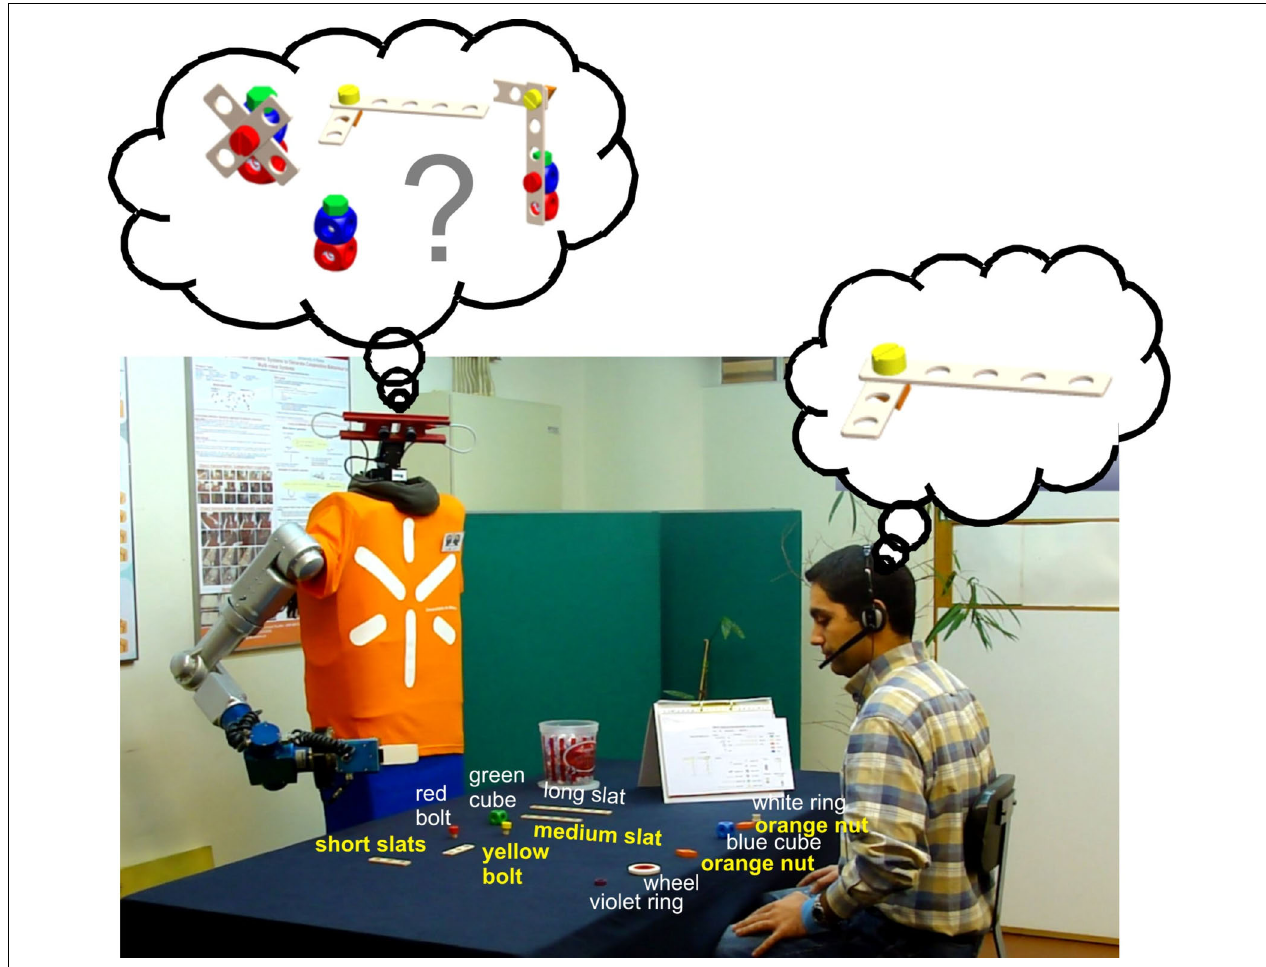
FIGURE 1 | Human–robot joint construction of different toy objects. The robot has fi rst to infer what toy object the human partner intends to build. Subsequently, the team constructs the target object from its components following an assembly